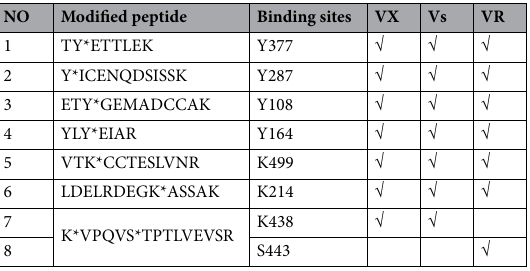
Table 2. Phosphonylated sites modified by V-type agents in human albumin.